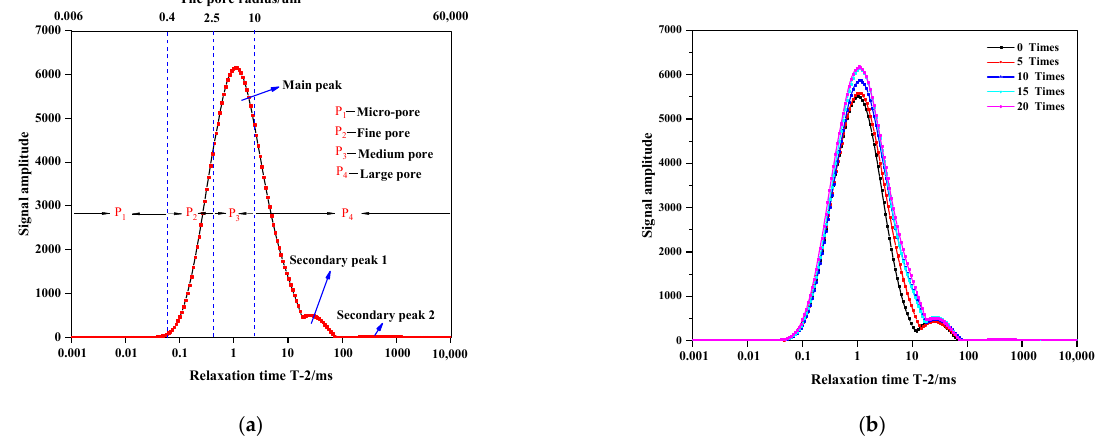
Figure 5. T-2 spectrum distribution curve of coarse-grained soil. ( a ) Division of peak regions; ( b ) T-2 time distribution curve.